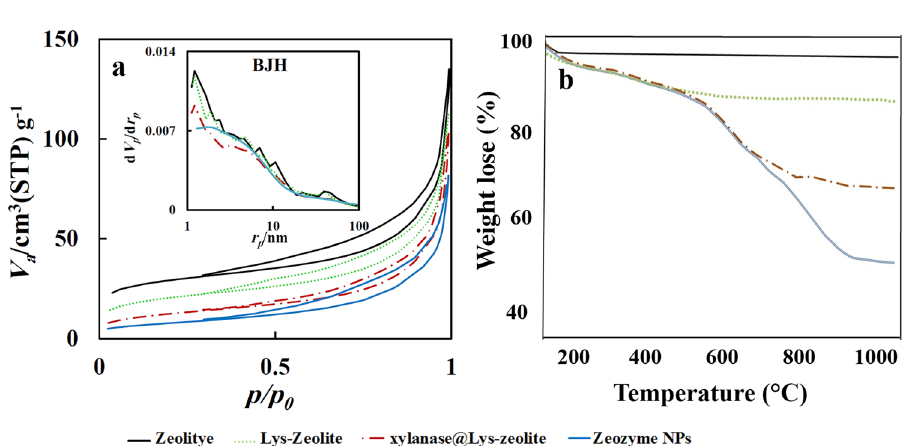
Figure 5. ( a ) The nitrogen sorption isotherm and BJH analysis (inset) of zeolite (dotted line), Lys-zeolite (black solid line), xylanase@Lys-zeolite (dash-dotted line), and Zeozyme NPs (blue solid line). ( b ) TGA analysis